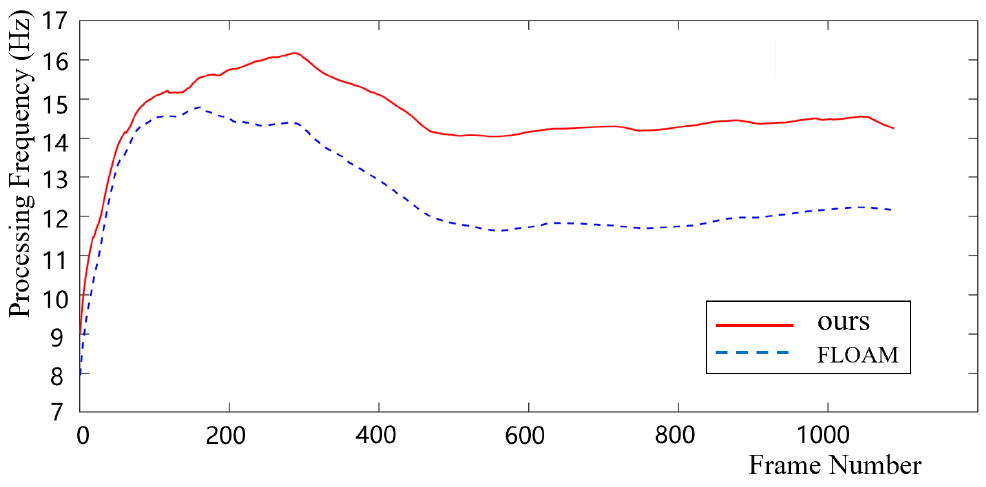
Figure 11. The processing frequency for each pose estimation.